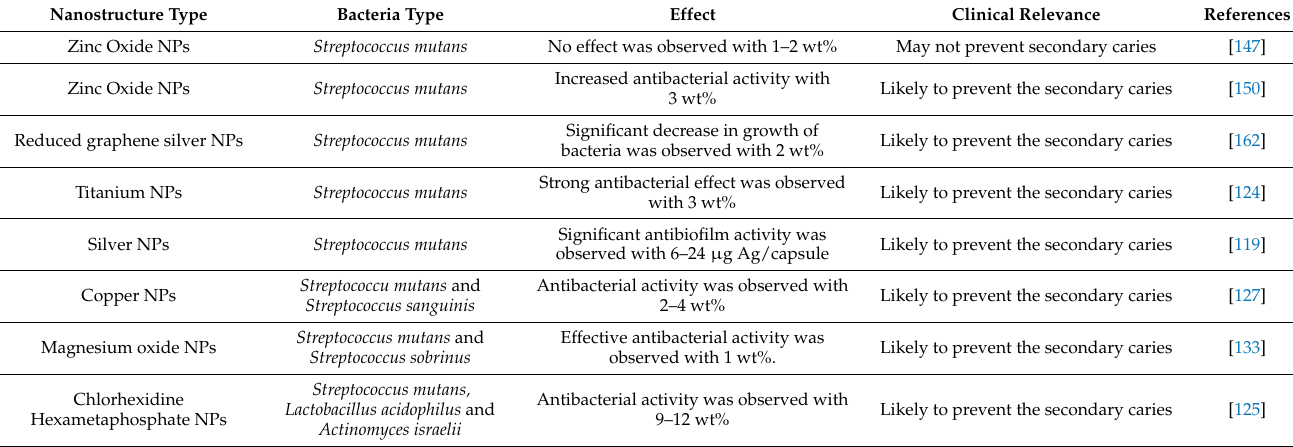
Table 4. Effect of the incorporation of various nanostructures on the antibacterial activity of